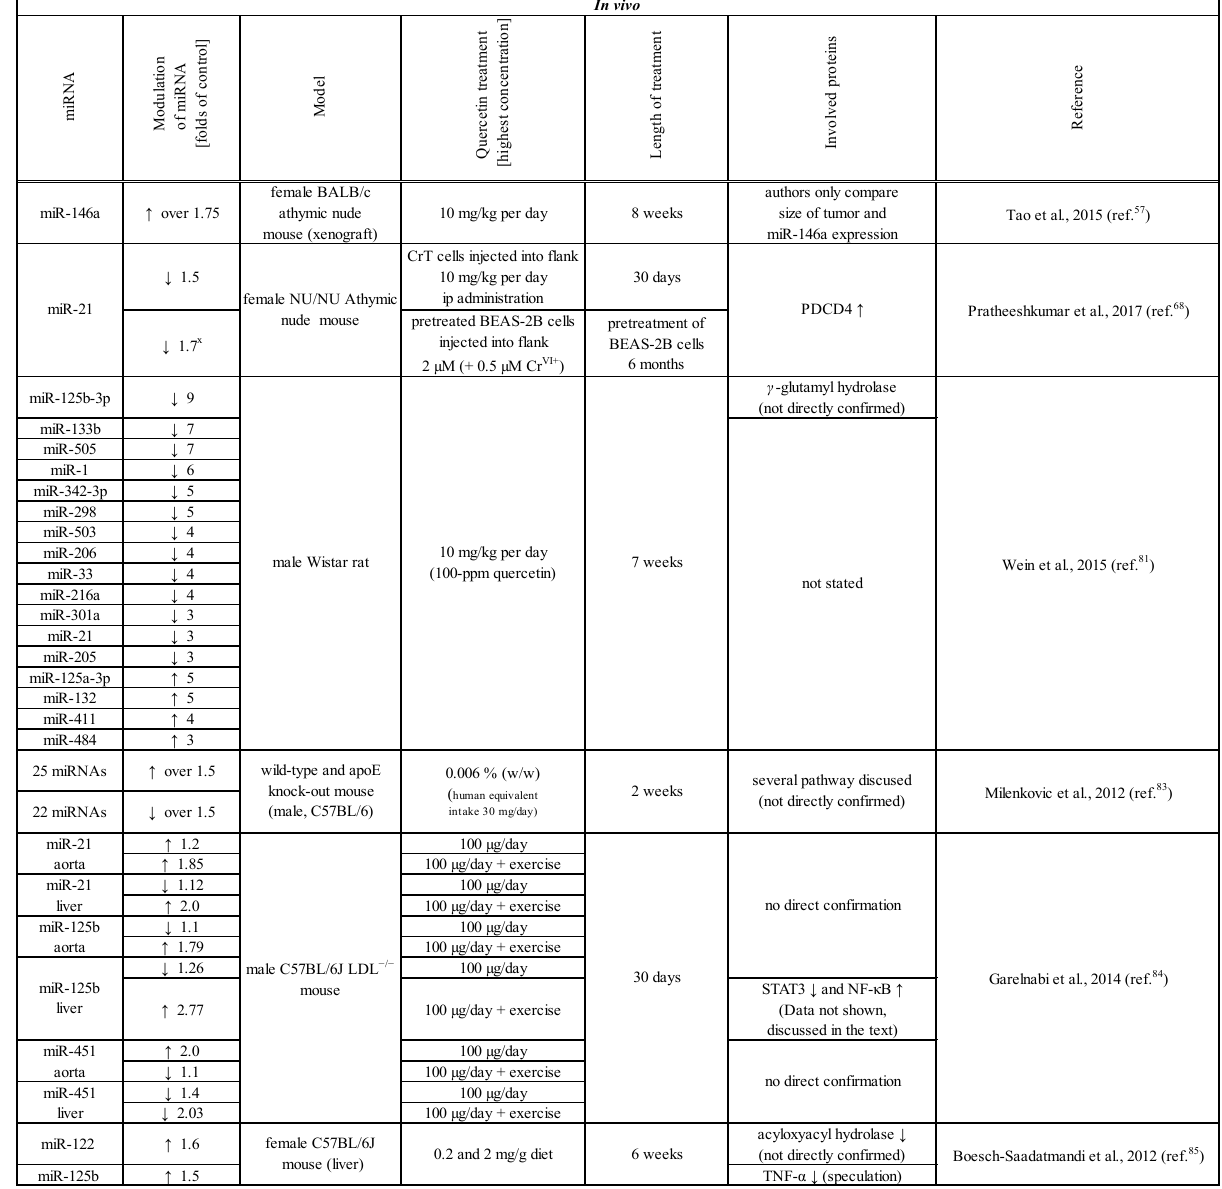
Table 2. Summary of quercetin mediated miRNAs with modulated targets and treatment dose of the compound characteristics – in vivo . The values for miRNA expression were usually estimated from article